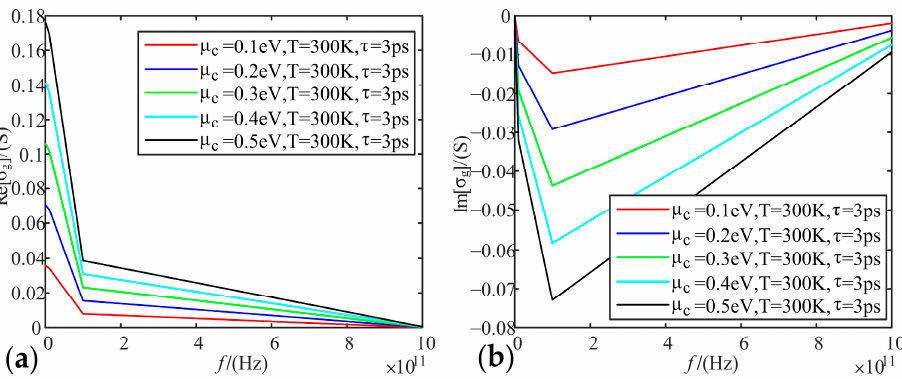
Figure 4. Variation of graphene total conductivity with frequency at different electrochemical po- tentials: ( a ) real part; ( b ) imaginary part.